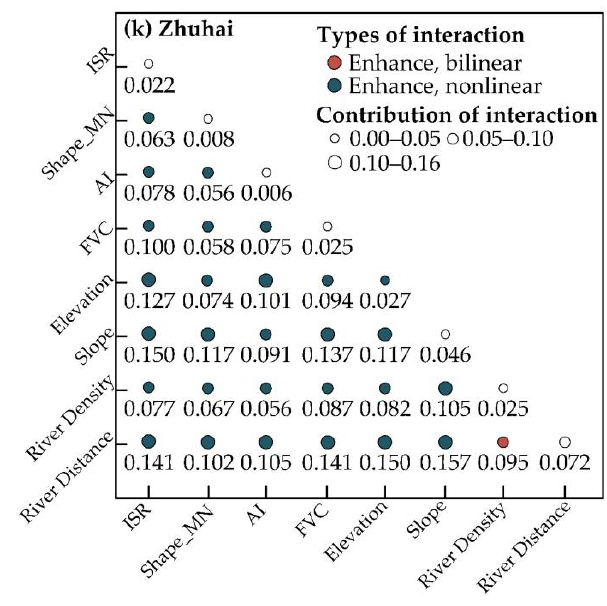
Figure 6. Interaction detector of the driving factors of rainstorm waterlogging in the whole GBA and in local